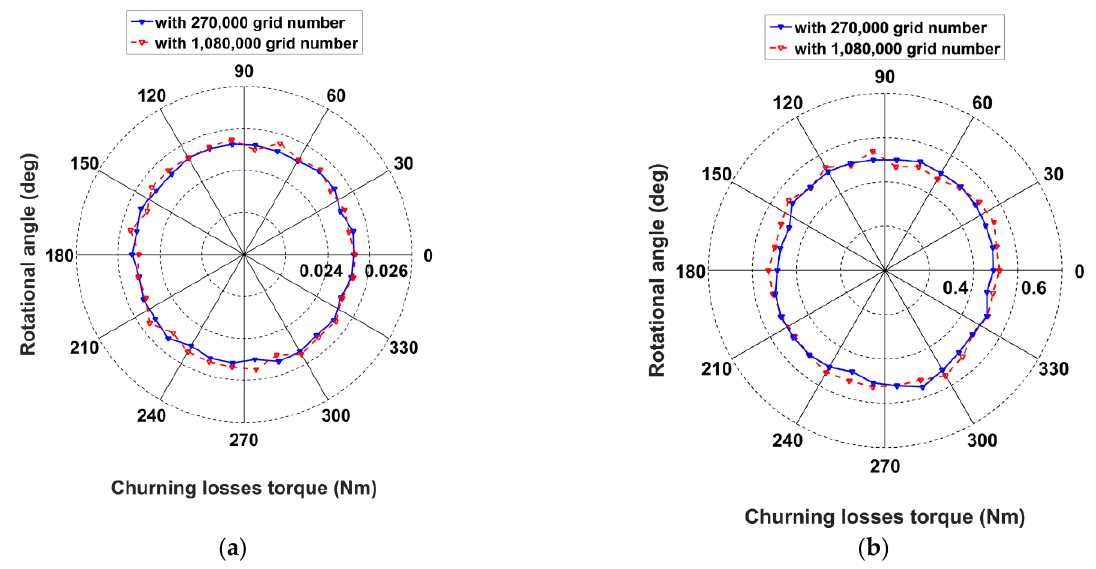
Figure 7. Comparison of the two grid numbers at the rotational speeds of ( a ) 1000 rpm and ( b ) 8000 rpm.